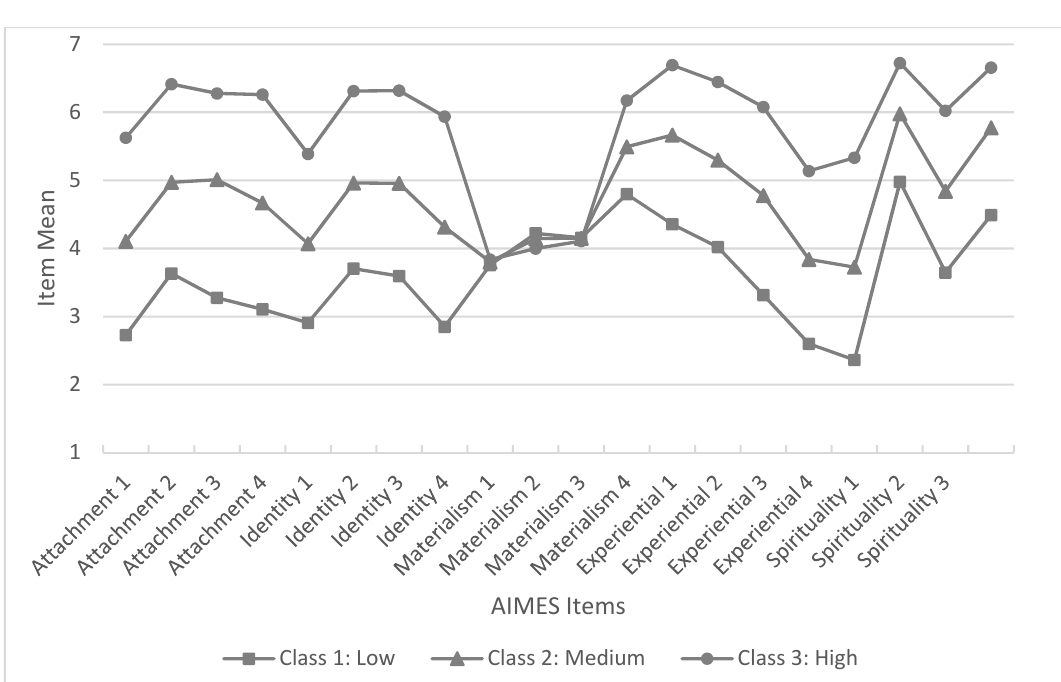
Figure 1. Items means for Subsample 1.